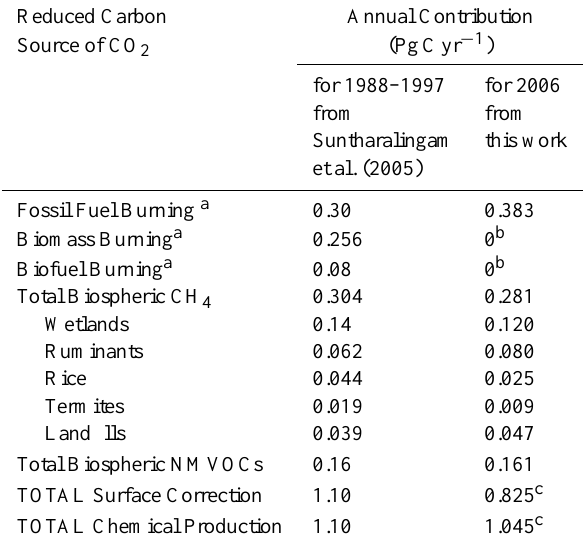
Table 2. Global annual component values for the surface correction that accompanies CO 2 chemical production from the oxidation of reduced carbon. The total surface correction and total chemical production are also